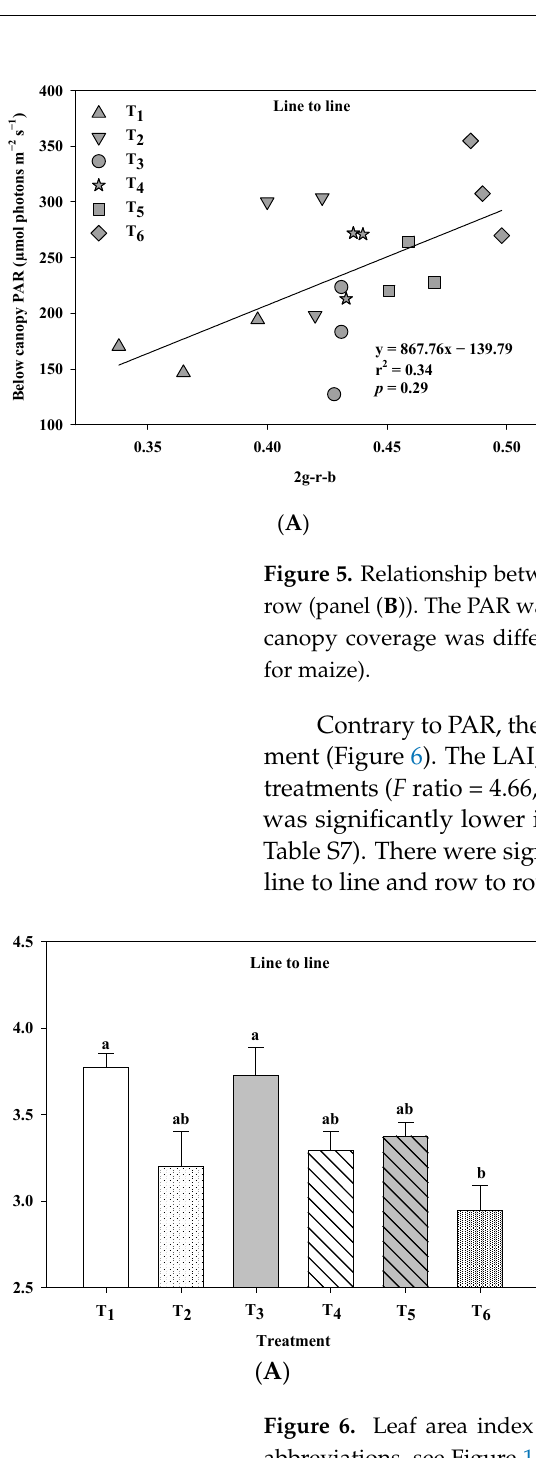
( B ) Figure 7. Relationship between 2 g-r-b and LAI, measured between the lines (panel ( A )) and be- tween rows (panel ( B )). The PAR was measured by taking reading in between lines (panel ( A )) and in between rows (panel ( B )) since canopy coverage was different due to spacing (line to line = 60 cm and plant to plant = 20 cm for maize) of the crops. 3.4. Performance of Intercropping Compared to sole cropping of cowpea, all the intercropped treatments and sole maize cultivation showed a better performance in terms of maize equivalent yield (Tables 5 and S11). The highest maize equivalent yield was recorded in T 3 (6.72 ± 0.46 t ha − 1 ), and the lowest maize equivalent ratio was found in T 1 (1.14 ± 0.06 t ha − 1 ). However, the perfor- mance of maize under sole and intercropping were similar in terms of maize equivalent yield. The LER was significantly greater in the intercropping system than in both sole cropping practices (F ratio = 35.26, p < 0.01, Table 5). Moreover, among intercropping prac- tices, it was significantly greater in T 6, LER (1.67 ± 0.05) than other treatments (e.g., LER (1.39 ± 0.09) at T 3 ).